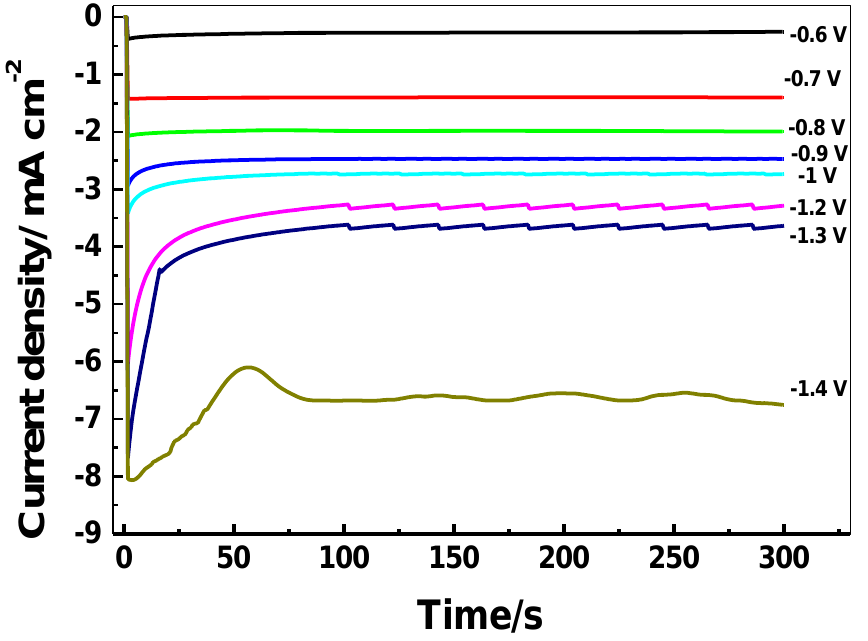
Figure 10. Current – time curves recorded with the Al-Ni-Gr cathode at a constant potential in an Figure 10. Current–time curves recorded with the Al-Ni-Gr cathode at a constant potential in an aqueous solution of 0.1 M Zn (NO 3 ) 2 and 0.05 M KNO 3. aqueous solution of 0.1 M Zn (NO 3 ) 2 and 0.05 M KNO 3